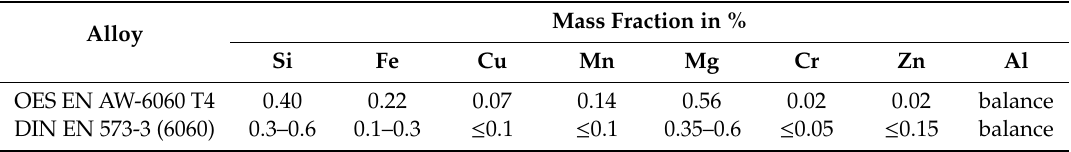
Table 1. Mass fraction of the alloying elements in the investigated